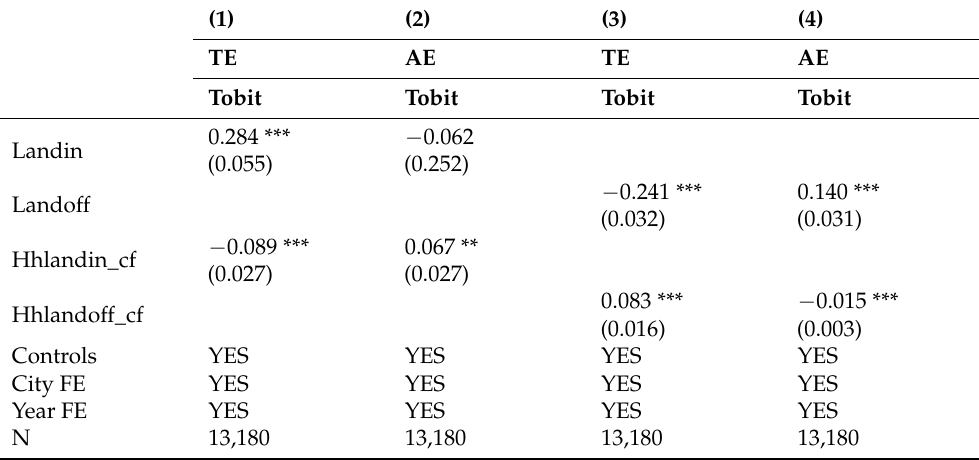
Table 6. Land transfer and rural Household efficiency: changing the samples of dependent variables.